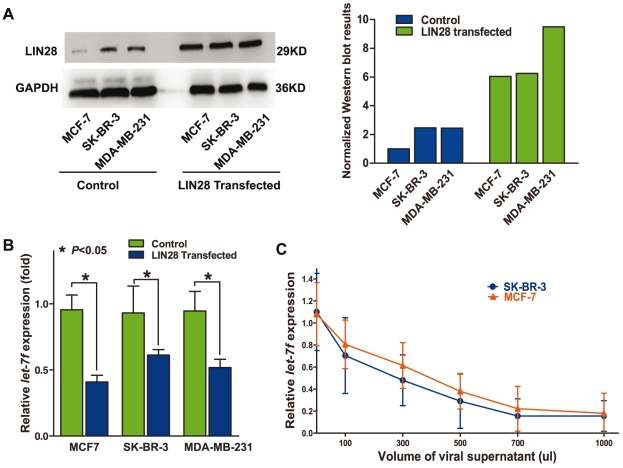
LIN28 represses let-7 in the molecular context of breast cancer.A, overexpression of LIN28 protein in different breast cancer cell lines. The left panel shows a representative Western blot detection of LIN28 protein in MCF-7, SK-BR-3, and MDA-MB-231 transfected with control or LIN28 overexpression vectors, respectively. The right panel shows the quantified results of the Western blot assay. LIN28 is normalized to the loading control GAPDH. B, upregulation of LIN28 downregulates mature let-7f levels. The panel shows the levels of let-7f in MCF7, SK-BR-3, and MDA-MB-231 cells transfected with either control vector or LIN28-expressing vector. Significantly lower levels of mature let-7f were detected in cells overexpressing LIN28. C, the level of LIN28 is inversely correlated with let-7f. SK-BR-3 and MCF-7 cells were infected with increasing amounts of LIN28 vectors (determined by the volumes of the viral supernatant). The let-7f levels were evaluated 48 h after infection. As shown in the graph, there was an inverse dose-dependent relationship between LIN28 and let-7f levels.